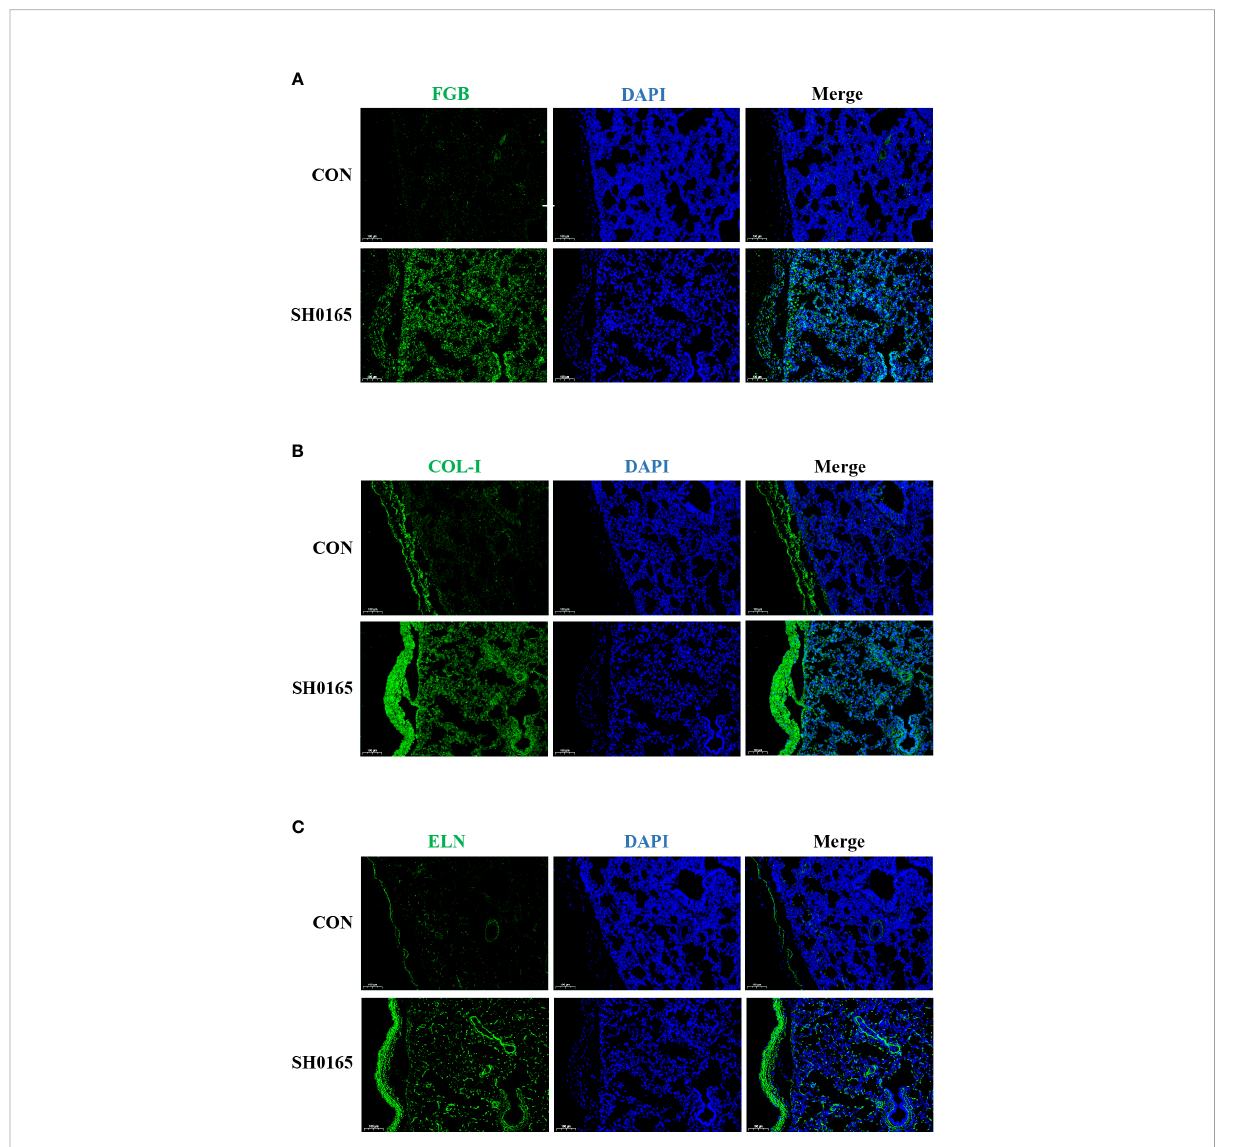
FIGURE 4 SH0165 infection caused the fi brin(ogen), COL-I and elastin enriched on thickened pleura. The distribution of FGB, COL-I and ELN. The distribution of FGB (A) , COL-1 (B) , and ELN (C) in lung tissue of piglets were detected via Immuno fl uorescence before and after SH0165 infection. Slides of the lung were stained with antibodies of FGB (A) , COL-1 (B) or ELN (C) (green), and DAPI (blue). Scale bar: 100 m